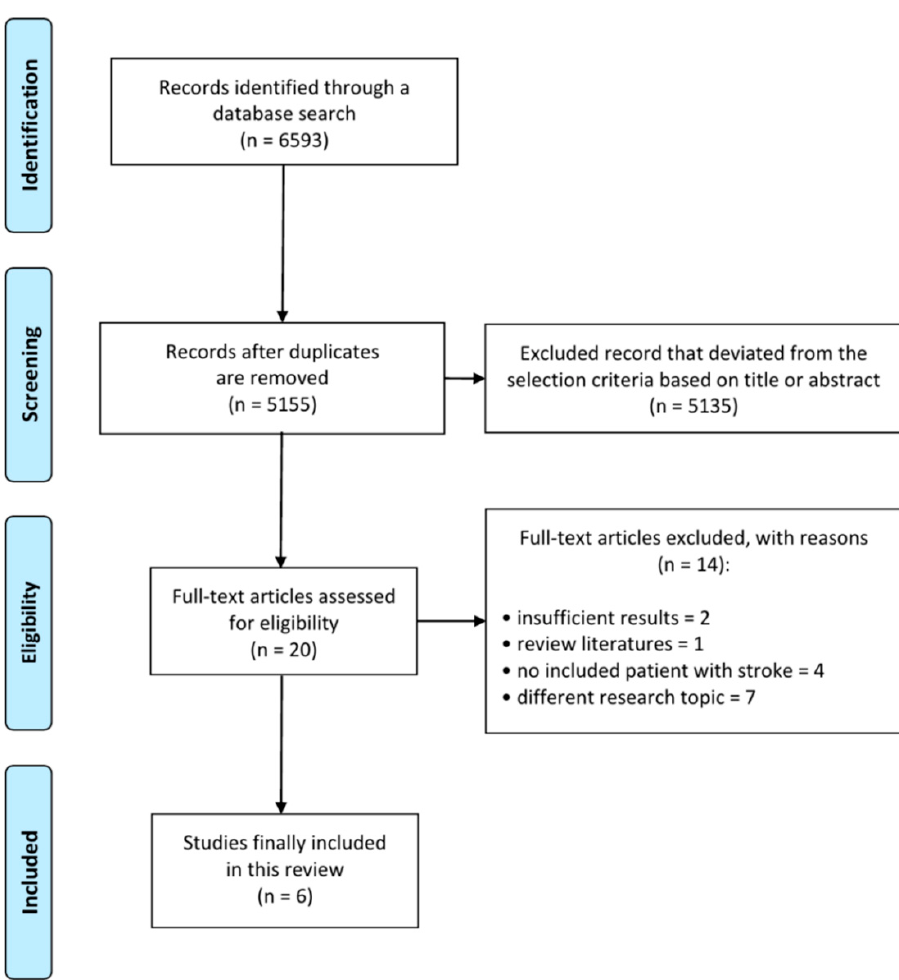
Figure 1. Flow diagram showing the search results of the meta-analysis.